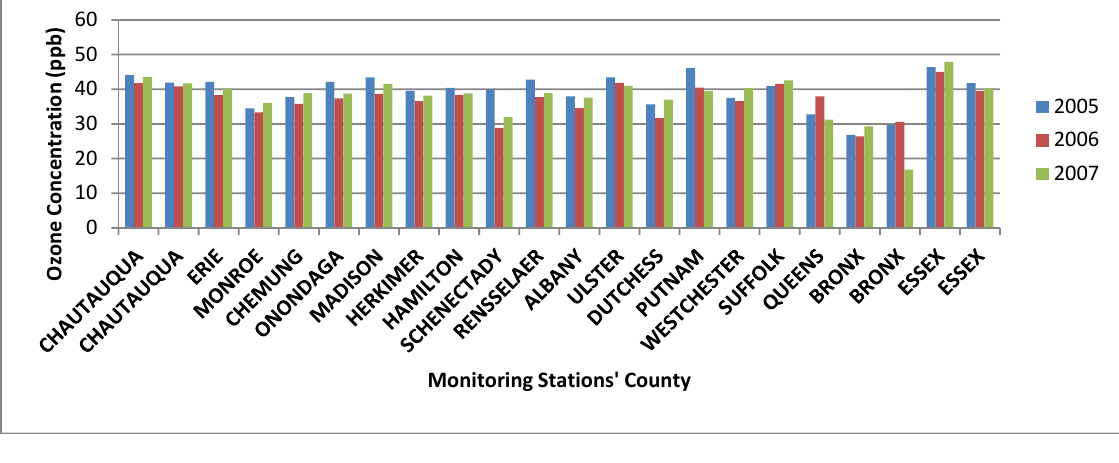
Figure 3. ( a ) Annual average concentration of ozone in various monitoring stations; ( b ) Annual average concentration of PM ( c ) Annual average concentration of SO